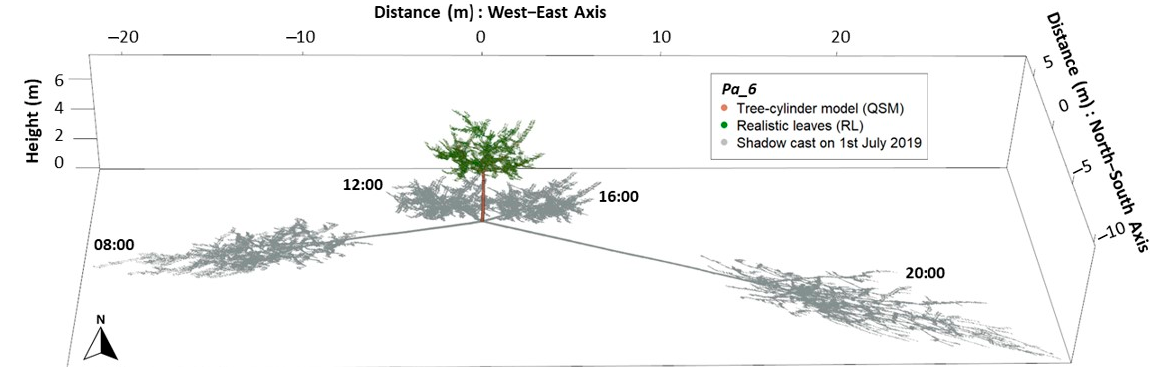
Figure 4. Modelled shadow projections of wild cherry tree Pa_6 (QSM with RL) on 1 July 2019, at four different times